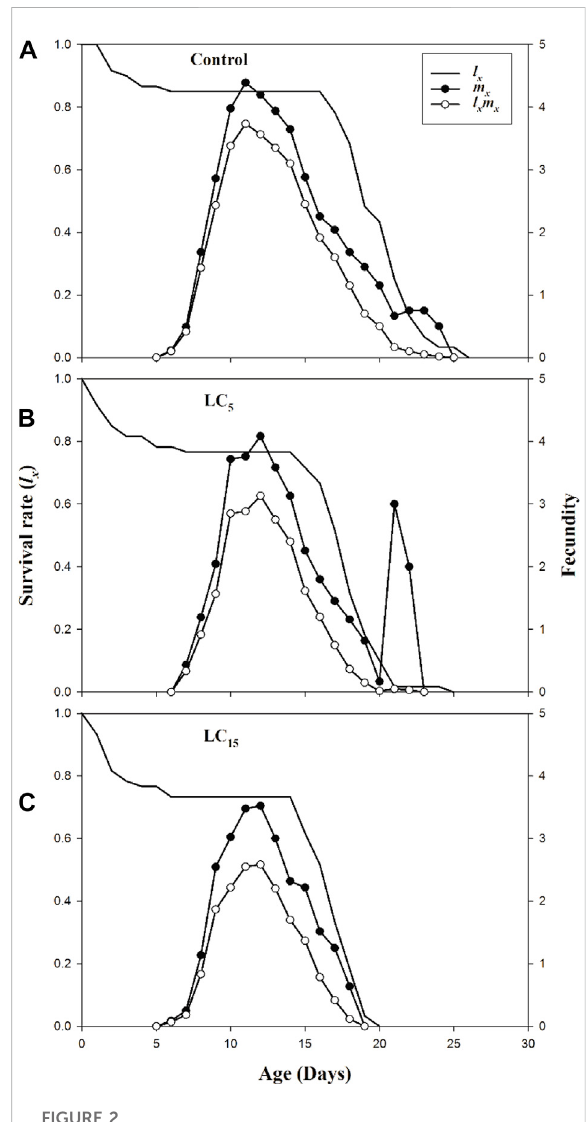
FIGURE 2 (A – C) : Age speci fi c survival rate ( l x ), age speci fi c fecundity ( m x ) and net maternity ( l x m x ) of control group (A) and B. brassicae treated with LC 5 (B) and LC 15 (C) of Spirotetramat in F 1